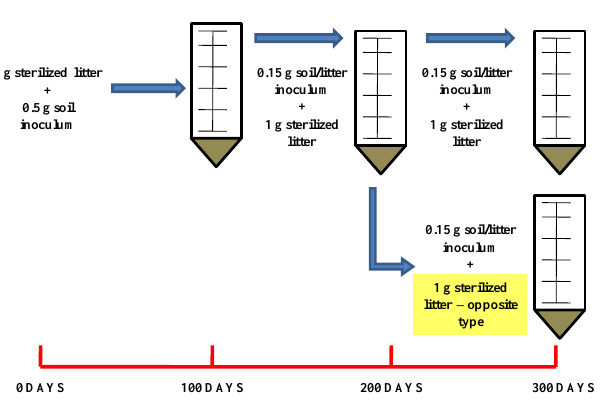
Fig. A1. Illustration of the experimental